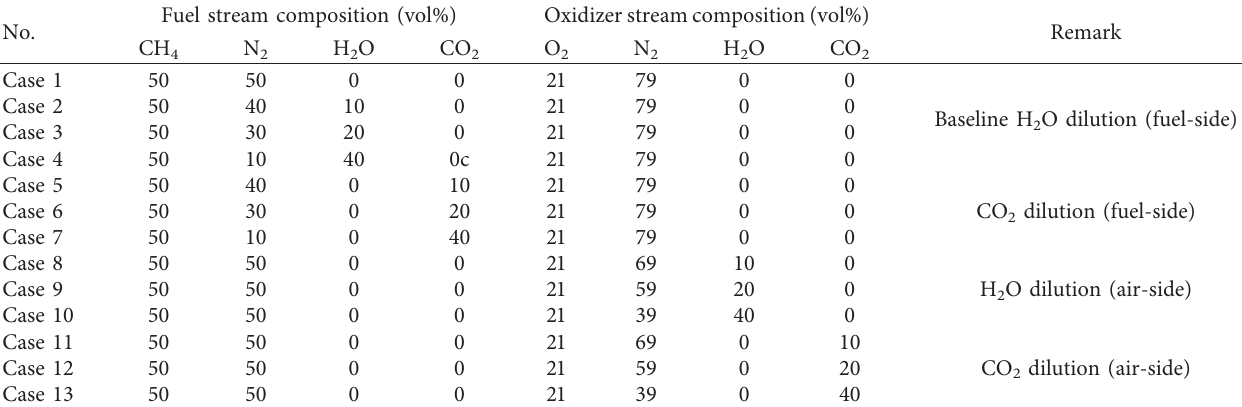
2 O or CO 2 replacement of N 2 , 400K, 1atm.